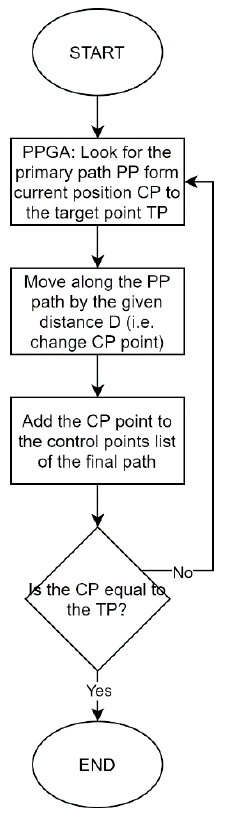
Figure 7. The Whole Path Generation algorithm (WPGA) flowchart.